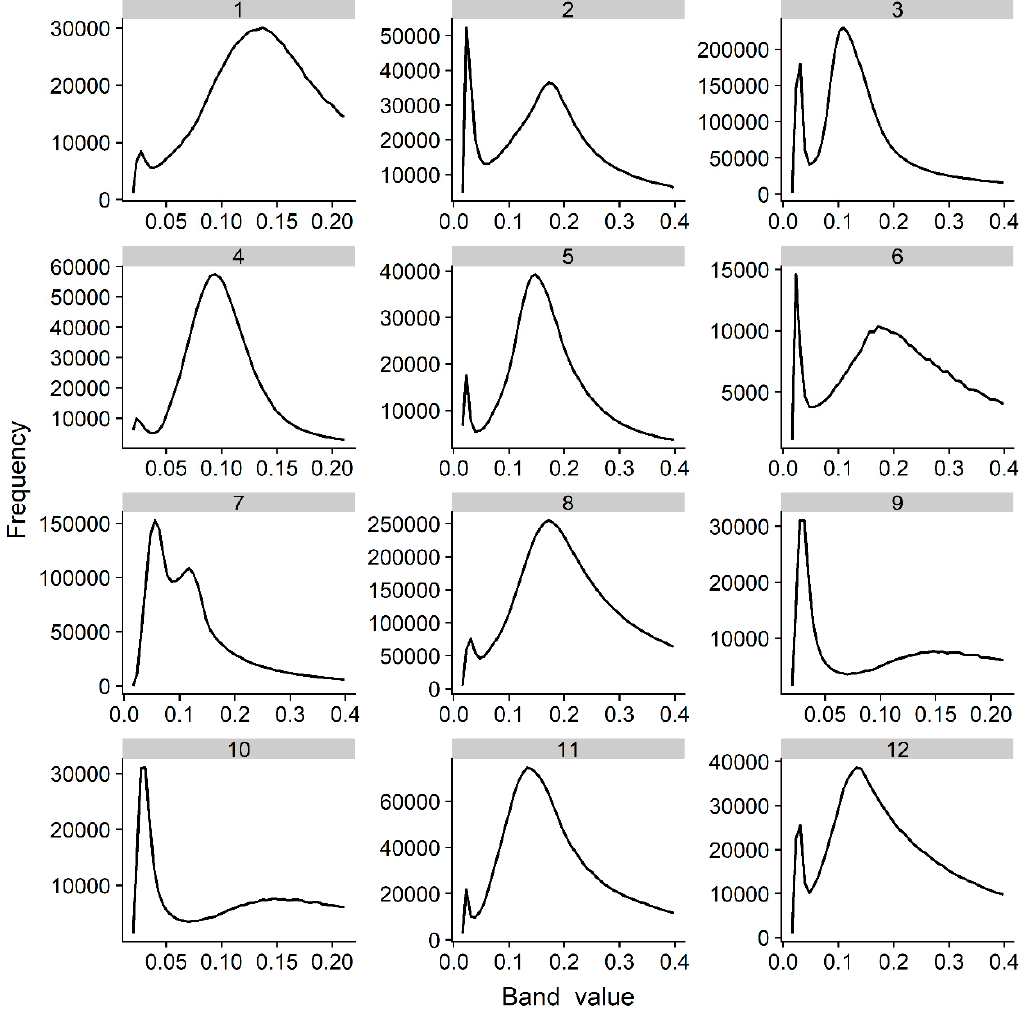
Figure 9. The histogram of σ °mean data for selected cities.